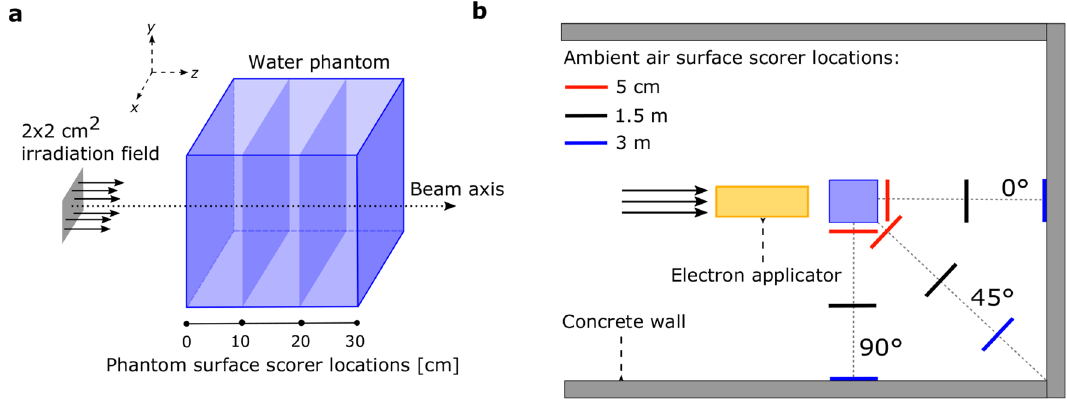
Figure 1. Schematic drawing of the TOPAS simulation, not drawn to scale and only for illustration purposes. (a) Surface scorer locations within the water phantom, and the irradiation field leaving the applicator. (b) Locations of all the scoring surfaces in the ambient air, along with the electron applicator, water phantom, and semi-infinite concrete